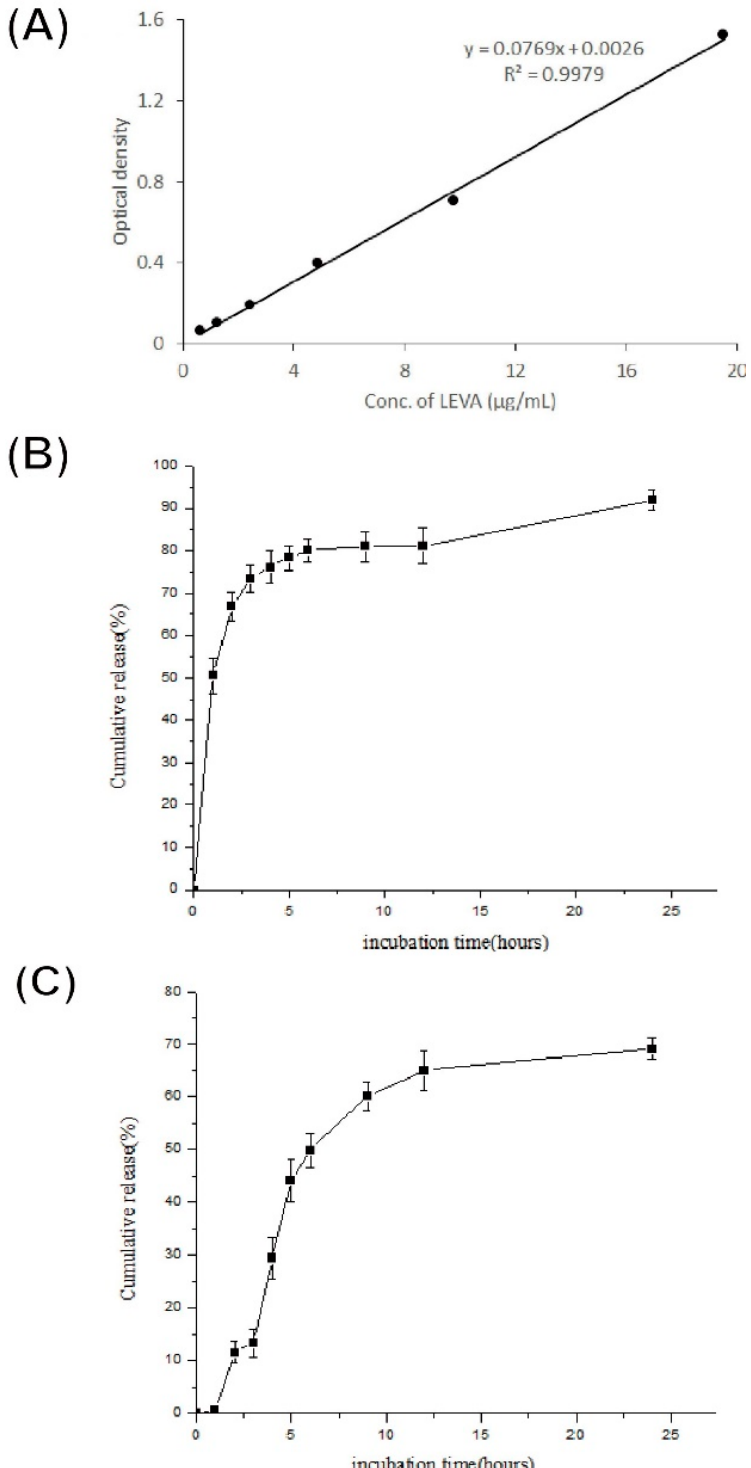
Figure 4. UV–vis spectrum of ( a ) a standard curve constructed from a series of LEVA solutions with known concentrations; ( b ) in vitro cumulative release profile of free form LEVA drug and ( c ) in vitro cumulative release profile of a suspension of LEVA/PVP/PMMA microparticles.